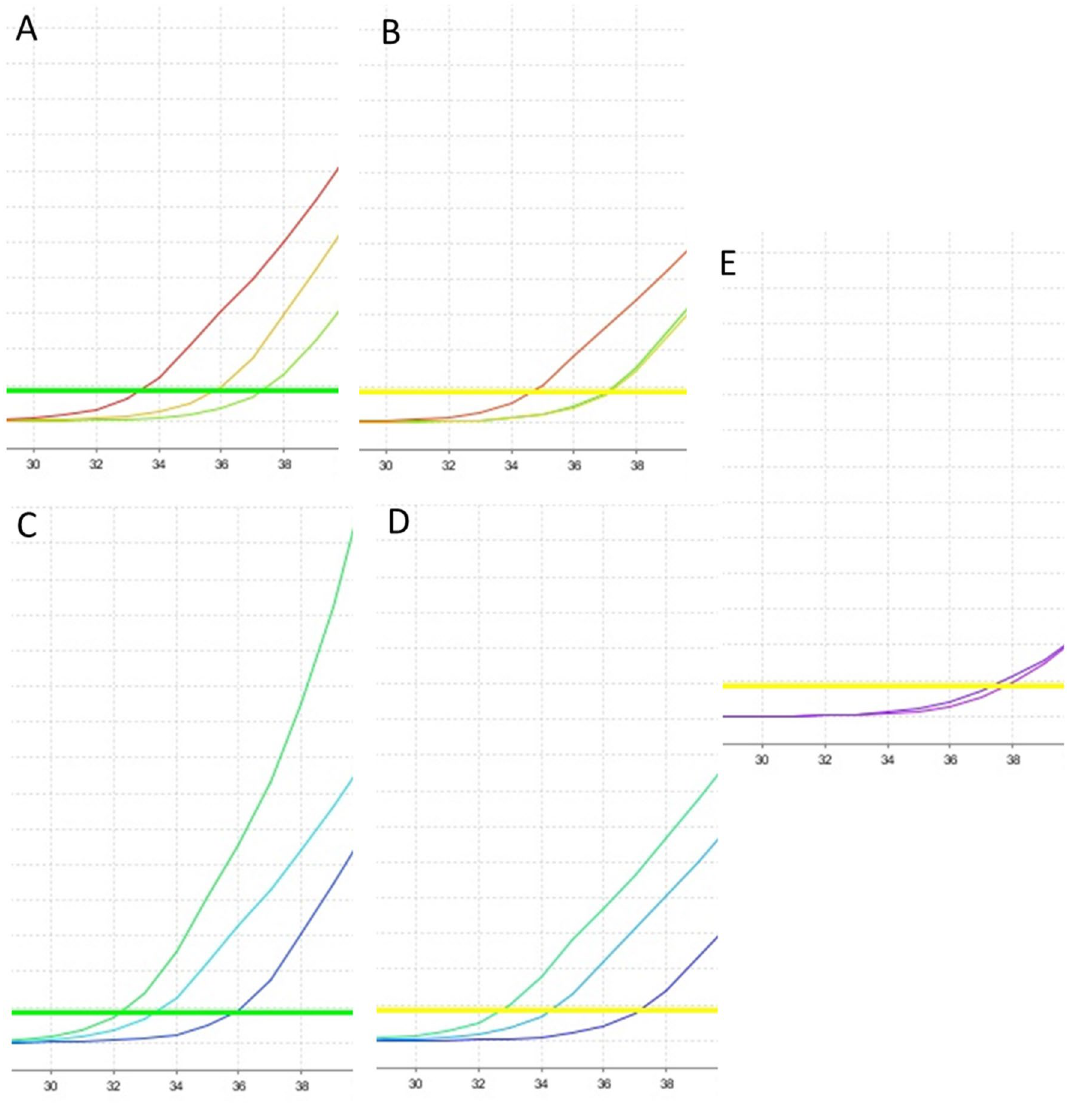
Figure 2. Real-time reverse-transcription amplification curves using master mix with uracil DNA glycosylase (UDG) activation. ( A ) Three dilutions of ssDNA from SARS-CoV-2 positive samples amplified by the 3 ′ primer of the hCOVassay1 set. ( B ) Three dilutions of ssDNA from SARS-CoV-2 positive samples amplified with the hCOVassay2 primer set. ( C ) Three dilutions of ssDNA from SARS-CoV-2 positive samples produced by the random primers methodology and amplified with the hCOVassay1 and hCOVassay2 primers ( D ). ( E ) Amplified negative controls for the two tested primer pairs. The negative control was from a negative